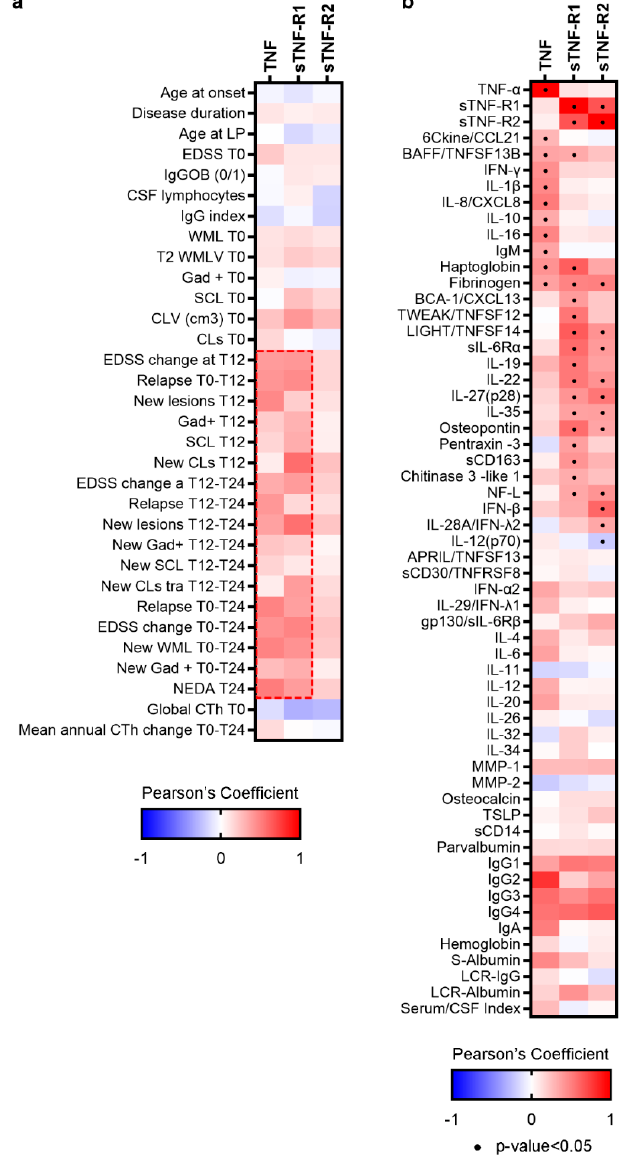
Figure 2. ( a ). Matrix indicating significant correlations (Spearman) between the examined clinical and MRI parameters and the CSF levels of TNF and sTNFRs. Blue colour shows negative correlation, red colour shows positive correlation; strong colour tonality identifies a strong correlation. ( b ). Matrix indicating significant correlations (Pearson) between the CSF levels of TNF and sTNFRs and the other examined molecules. Blue colour shows negative correlation, red colour shows positive correlation; strong colour tonality identifies a strong correlation. By performing pathway analysis of the CSF inflammatory patterns associated with TNF or TNF-R1/2 expression, we found that the TNF-associated profile encompassed the highest number of canonical pathways (n = 66) compared to the sTNF-R1 and sTNF-R2 patterns (n = 35 and n = 38, respectively; Figure 3a,b). Twenty-nine pathways were shared among the three patterns, but the TNF-associated profile showed lower p -values in gen- eral (i.e., higher − log10( p -value)) compared to the other two profiles, which were fairly